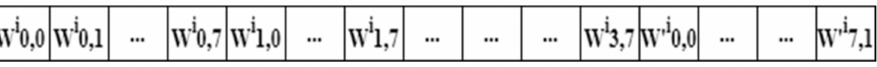
Figure 3. The genetic algorithm (GA) chromosome.